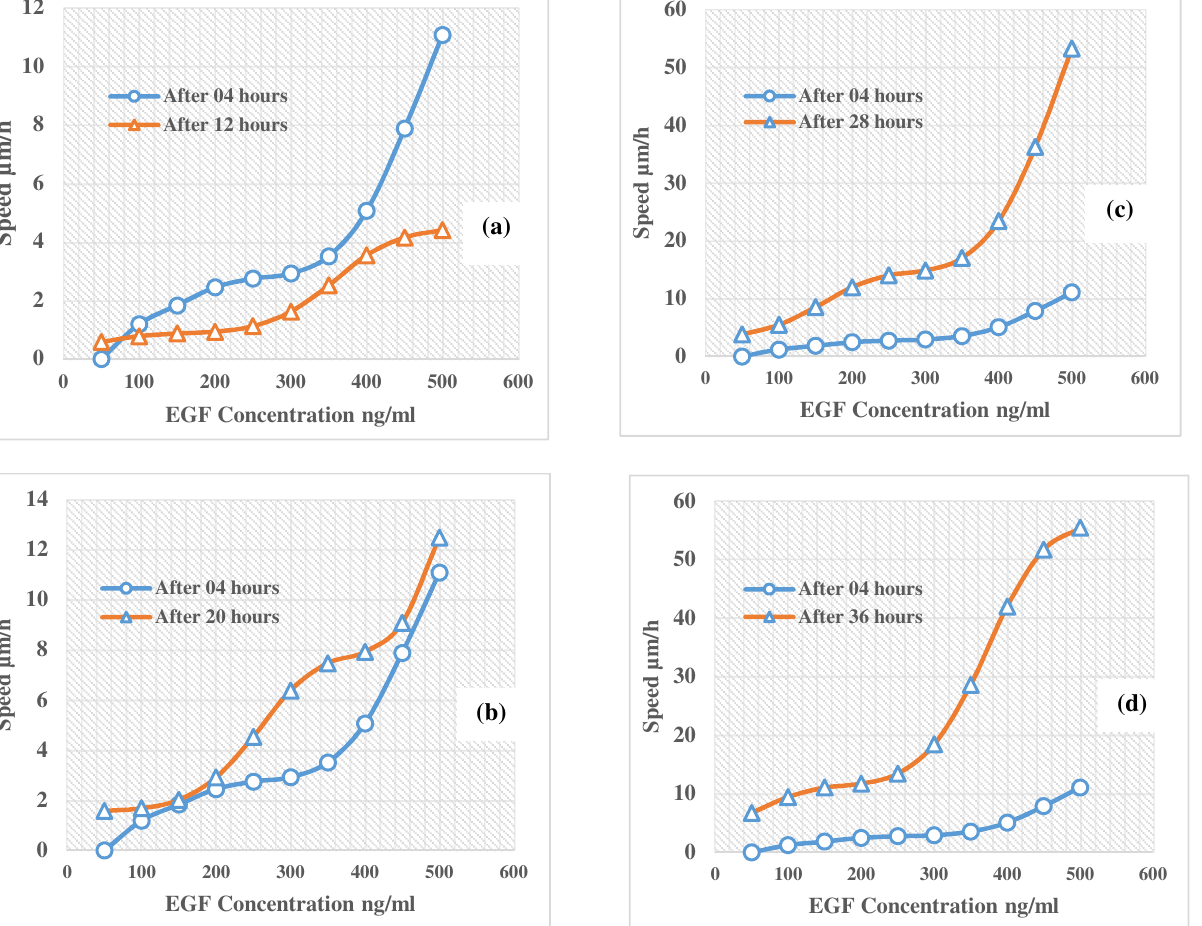
Fig. 13. Tangential speed of healing with respect to the cell concentration of EGF for 4 steps: (a) 12h, (b) 20h, (c) 28h and (d) 36h compared with 4